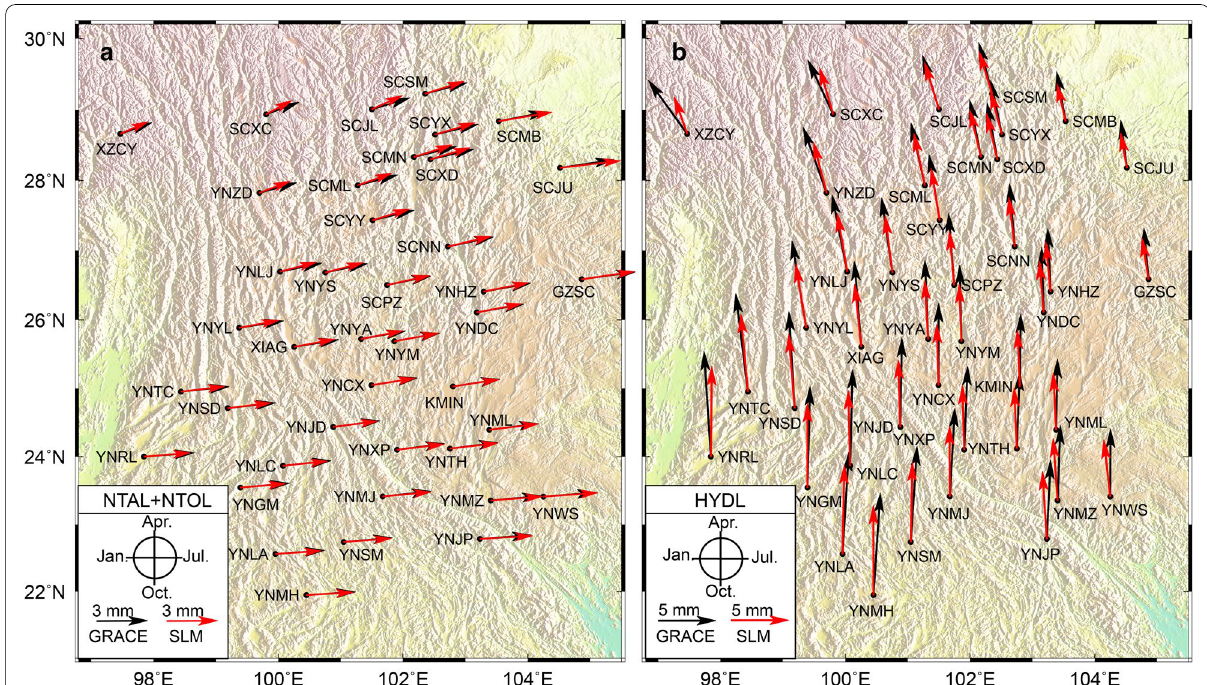
Fig. 4 Phases and amplitudes of different loading components. a Non-tidal atmospheric loading (NTAL) hydrological loading